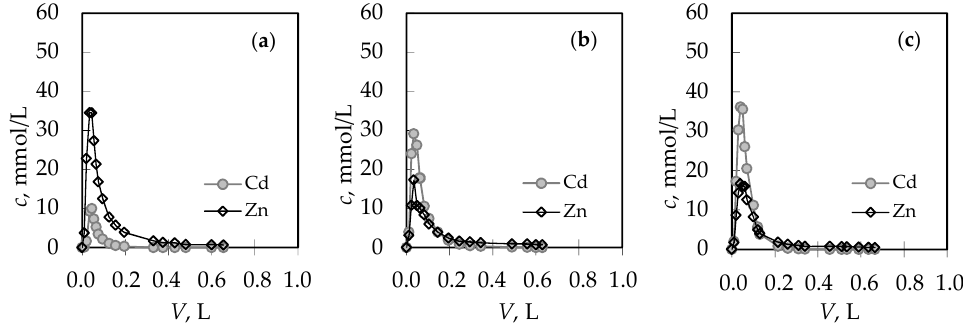
Figure 8 . Regeneration curves for each metal ion obtained after service cycles with different Cd/Zn ratios: ( a ) 0.14 ; ( b ) 1.07 ; ( c ) 1.93.